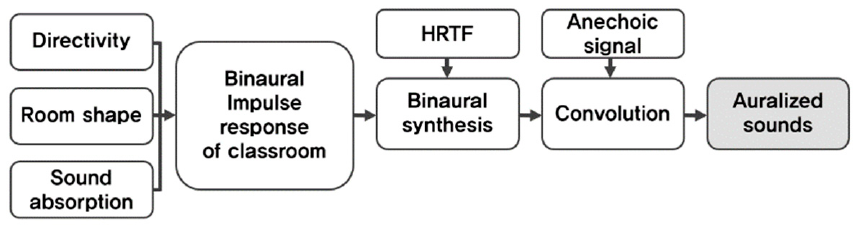
Figure 6. Production process of auralized materials.